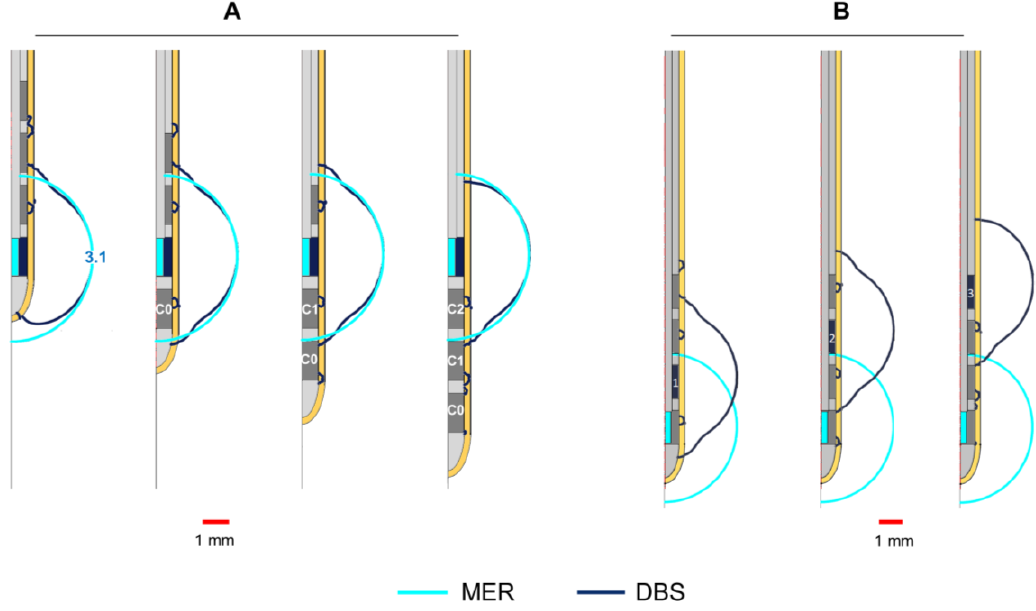
Figure 4. Influence of non-active contacts for DBS. EF simulated in homogeneous grey matter (0.123 S/m) depicted with 0.2 V/mm isocontours. ( A ) Activation of each DBS contact displacing the DBS lead to align the middle point of the active contact (dark blue) to that of the MER stimulation contact (cyan). Numbers in front of the active contact of the first lead indicate the maximal EF extension measured from the lead’s axis. ( B ) Activation of each DBS contact while the first contact (C0) is aligned to the middle point of the MER stimulation contact. The DBS contacts were set to 3 V one at the time and the MER stimulation contact was set to 3 mA. Non-active contacts (in dark grey) were set to floating potential. Maximal extension obtained for the MER and DBS contacts: 3.1 mm.